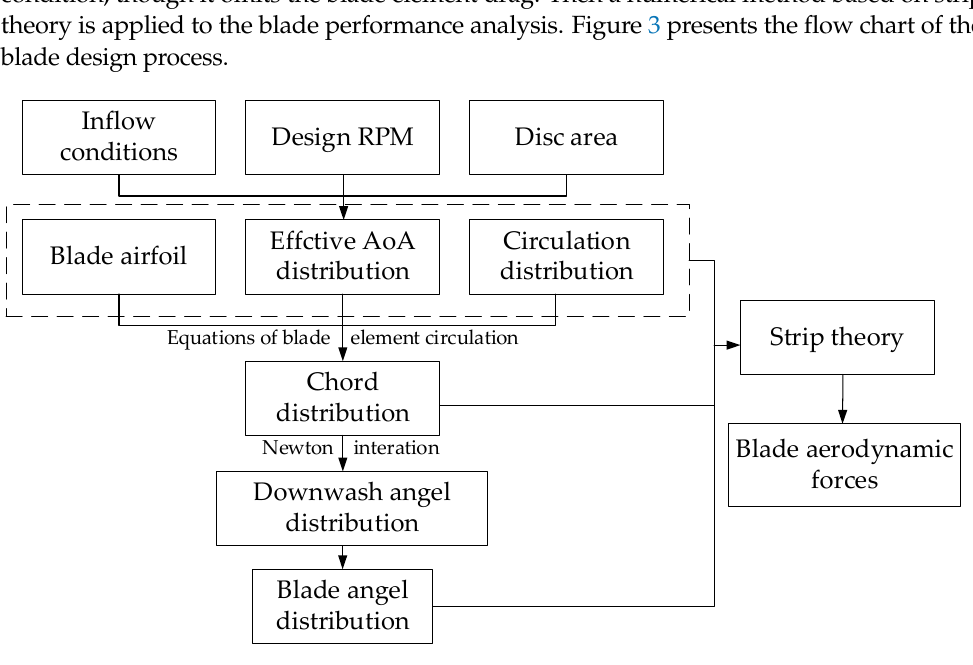
Figure 3. Flow chart of the blade design